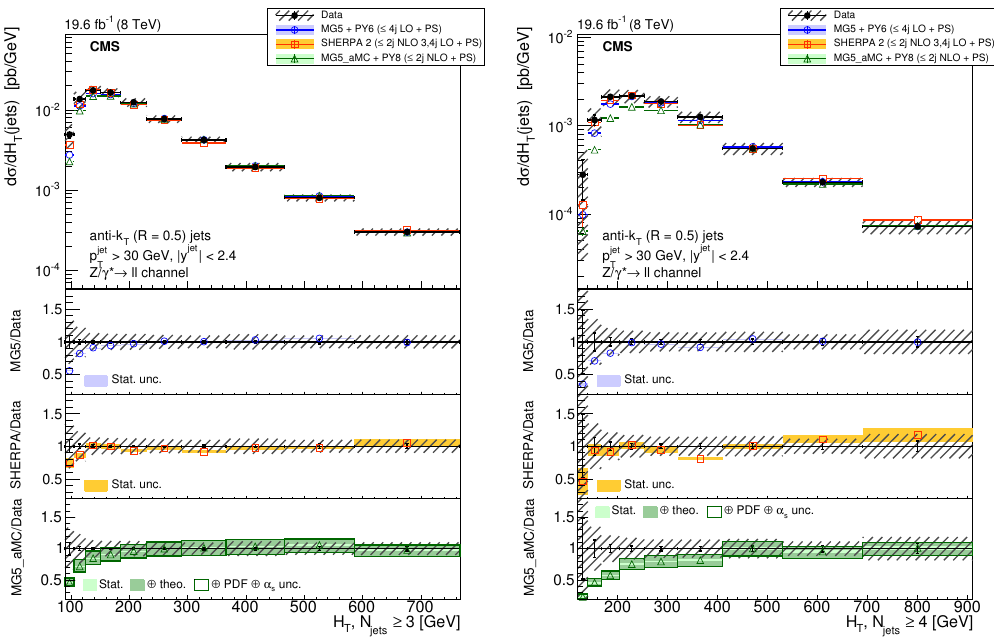
Figure 16 . The di(cid:11)erential cross section for Z ( ! ‘‘ ) + jets production measured as a function of H T for (left) N jets (cid:21) 3 and (right) N jets (cid:21) 4 compared to the predictions calculated with MadGraph 5 + pythia 6, sherpa 2, and mg5 a mc + pythia 8. The lower panels show the ratios of the theoretical predictions to the measurements. Error bars around the experimental points show the statistical uncertainty, while the cross-hatched bands indicate the statistical and systematic uncertainties added in quadrature. The boxes around the mg5 a mc + pythia 8 to measurement ratio represent the uncertainty on the prediction, including statistical, theoretical (from scale variations), and PDF uncertainties. The dark green area represents the statistical and theoretical uncertainties only, while the light green area represents the statistical uncertainty